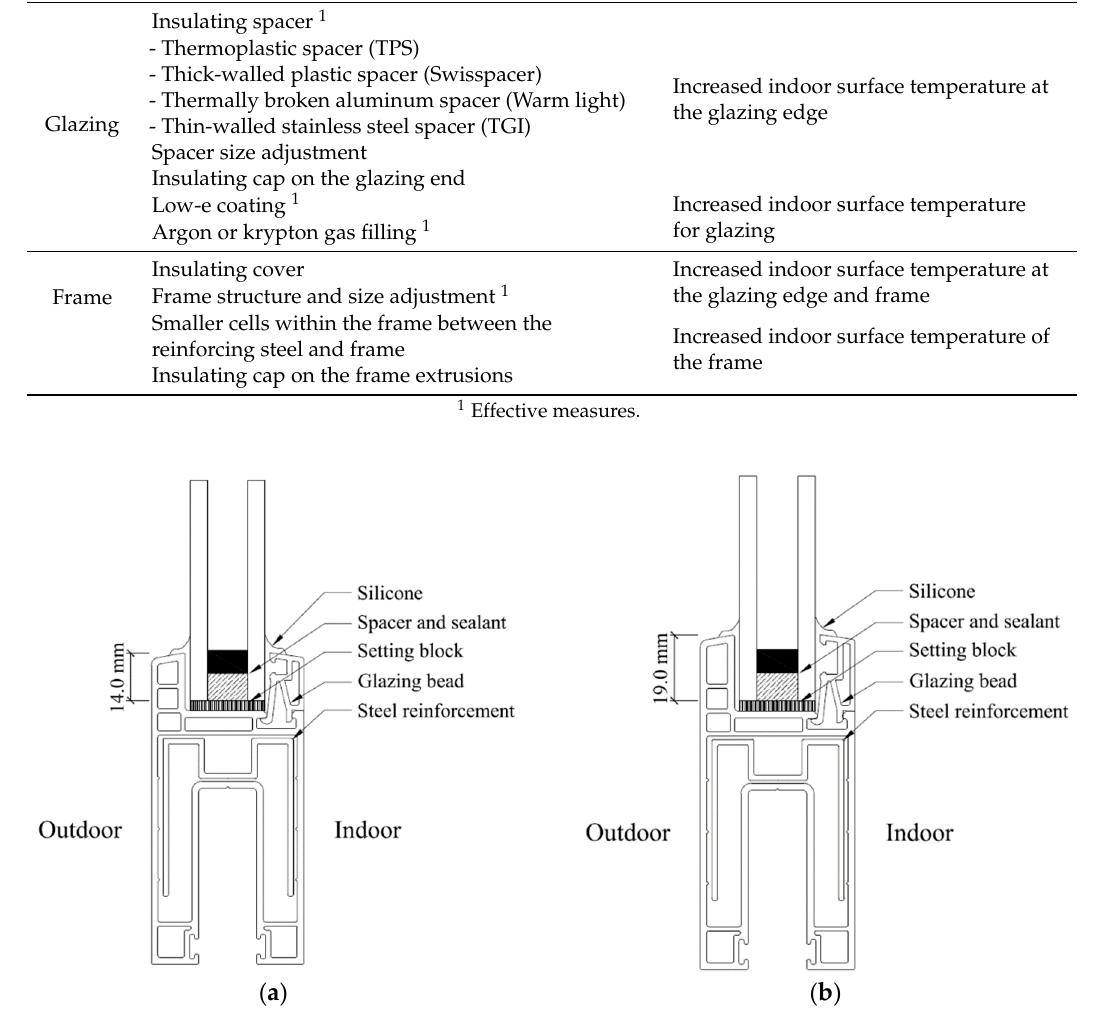
Figure 3. Concept of frame structure and size adjustment: ( a ) existing case; ( b ) alternative (the frame height overlapping the glazing is extended by 5 mm).